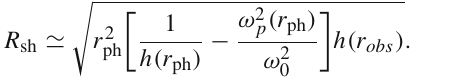
quency is changing. In the right panels, plasma frequency and q 2 are fixed but q 1 is changing. If q 1 → 0, the radius of photon orbit is the same as with Schwarzschild BH